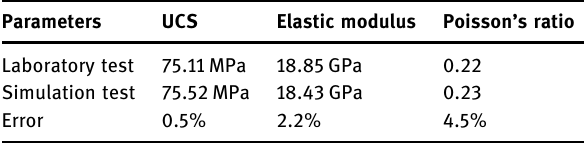
Table 2: Mechanical parameters of marble and numerical model Parameters